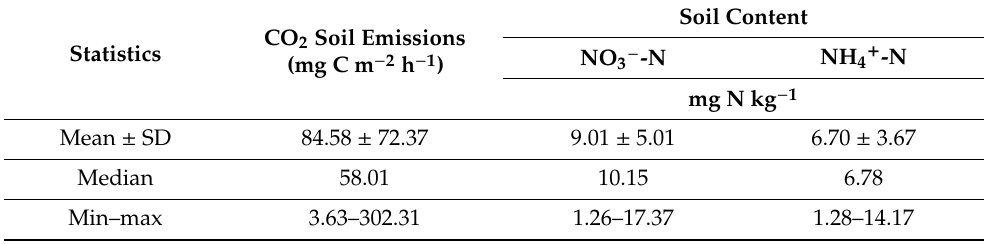
Table 1. Average CO 2 ‐ C soil emissions and NO 3 − ‐ N and NH 4+ ‐ N content in the soil.